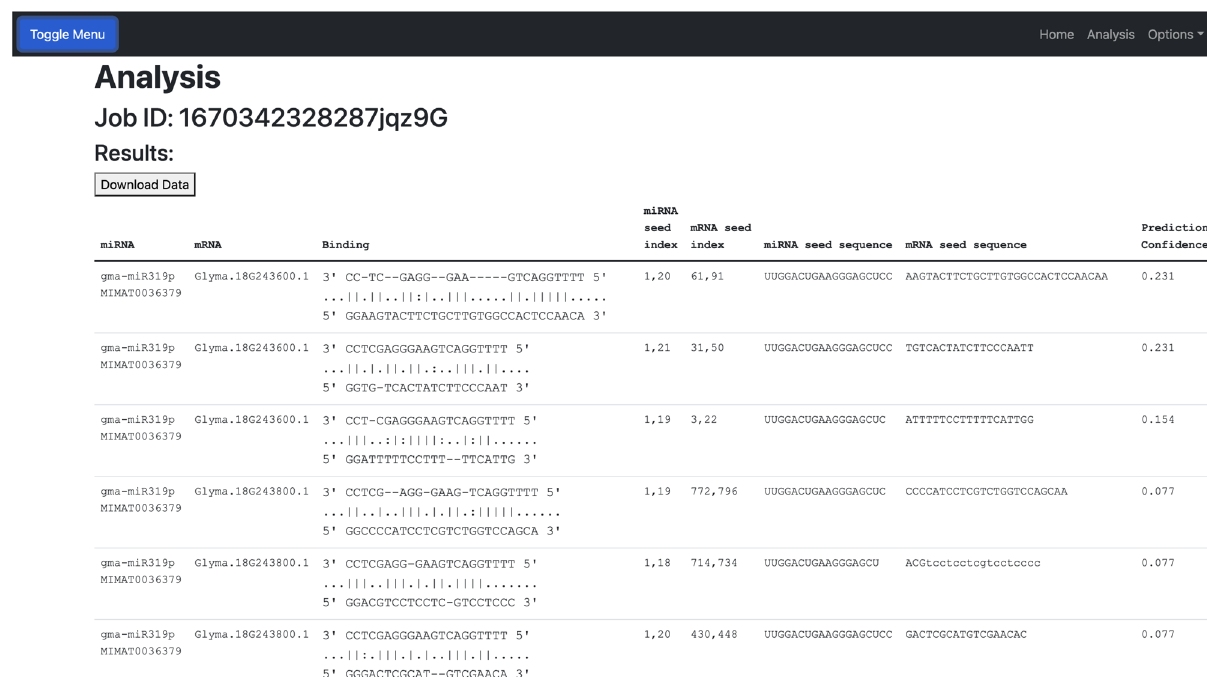
Figure 5. A screenshot of example results of a job submission on P-TarPmiR web server. The results page includes the predicted binding of the seed location, the index of the predicted seed location on the miRNA and mRNA, the miRNA and mRNA seed sequences, and the prediction confidence of the miRNA–mRNA